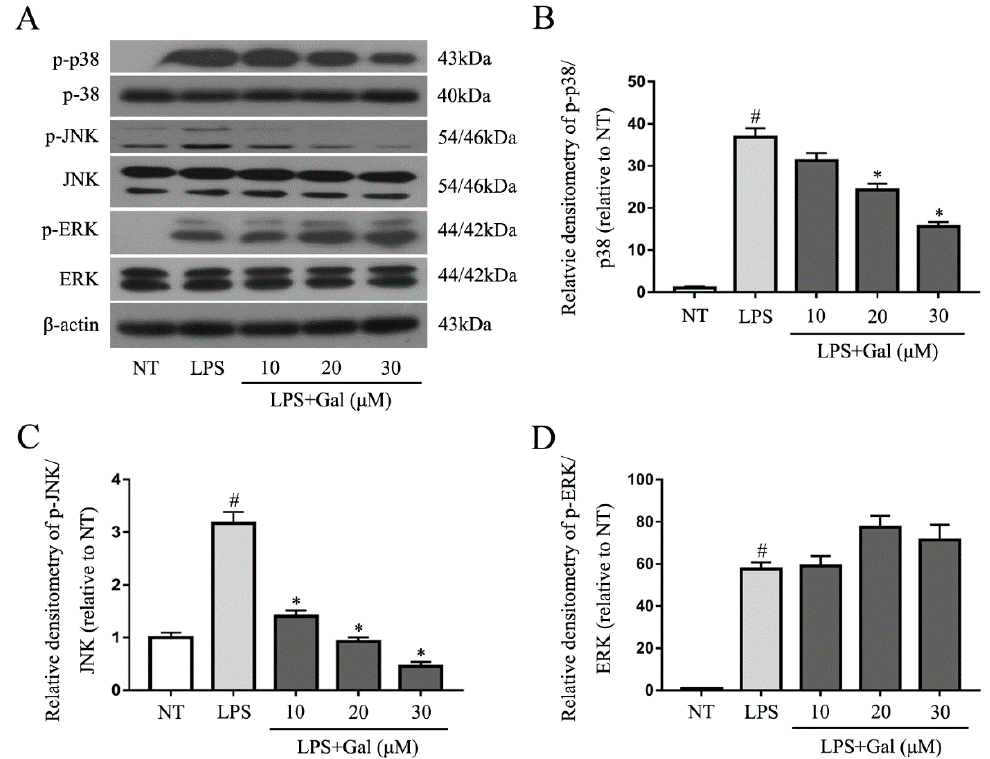
Figure 5. Galangin inhibited the phosphorylation of p38 and JNK. ( A ) Western blot analysis for the phosphorylation of p38, JNK, and ERK ( n = 3). Cells were pretreated with various concentrations of galangin (10, 20, and 30 μ M) for 1 h, followed by stimulation with LPS for 1 h, then collected. Western blot analysis was performed using antibodies against phospho- or total forms of ERK, p38, and JNK ( B – D ) Quantification of western blot data of p-p38, p-JNK, and p-ERK. Data are shown as means ± SD. # p < 0.05 compared to the NT group, * p < 0.05 compared to the LPS group.